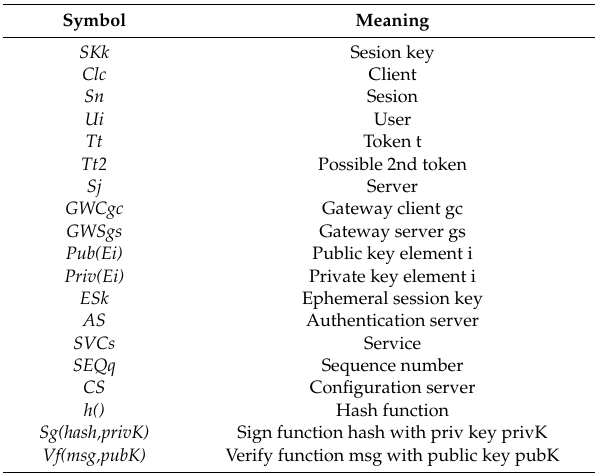
Table 3. Relation of the notation of the components used.